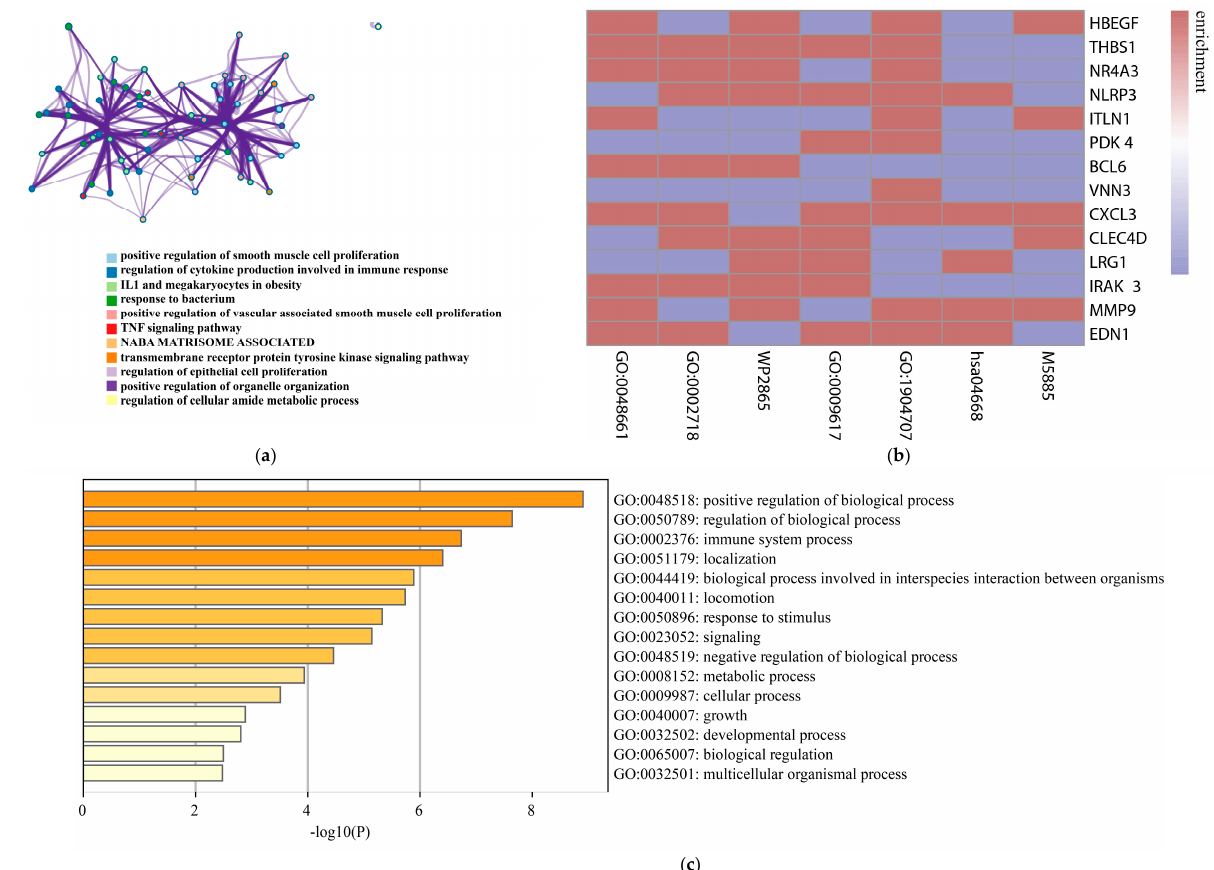
Figure 4. Enrichment of DCCGs. ( a ) Network of enriched terms: colored by cluster ID, where nodes that share the same cluster ID are typically close to each other. ( b ) Enrichment map of genes, where red indicates functional enrichment of genes and blue represents without enrichment. ( c ) The top-level GO biological processes of